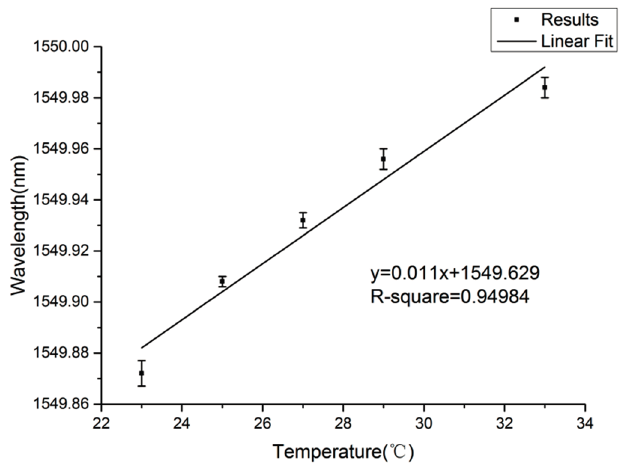
Figure 6. The relationship between resonant wavelength and temperature and the linear fitting with 2.45- μ m-diameter fiber. The error bars show the differences between experimental and fitting results.